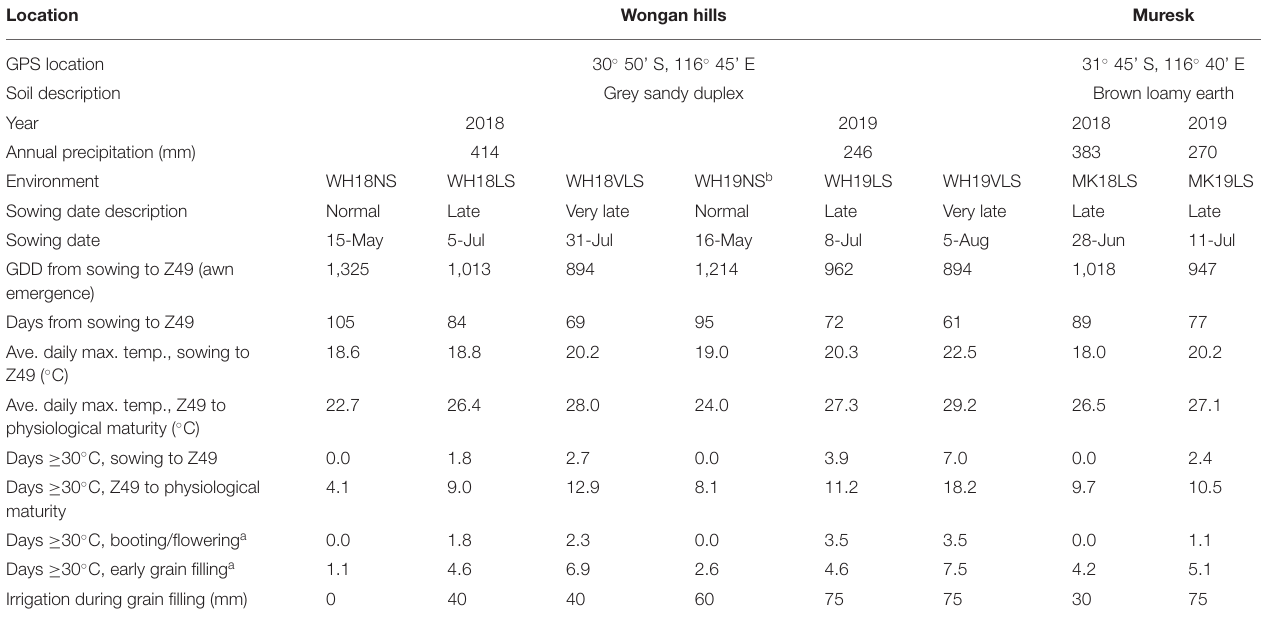
TABLE 1 | Summary of sowing dates, awn emergence times, and weather experienced in trials at Wongan Hills (WH) and Muresk (MK) in 2018 and 2019 crop growing seasons. Location